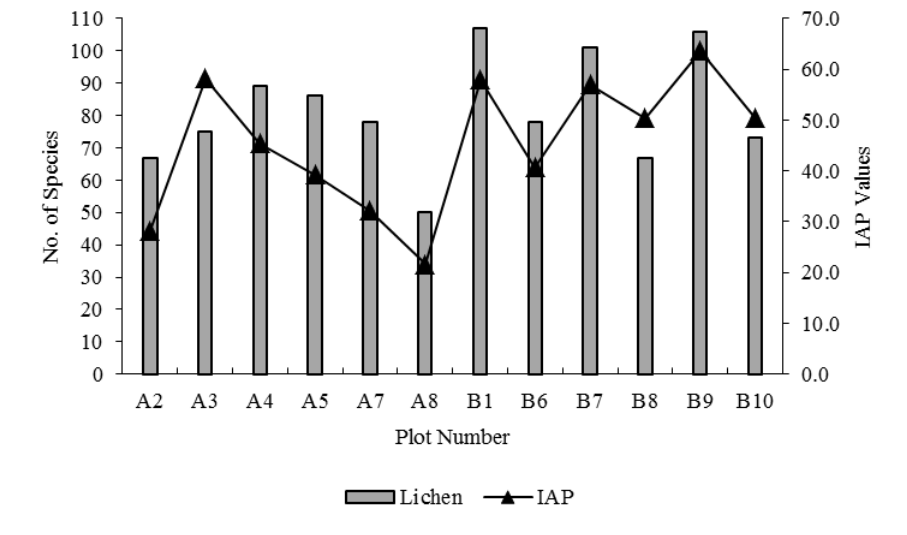
Figure 6: Number of lichen species recorded in each plots and their correspondent IAP values at the